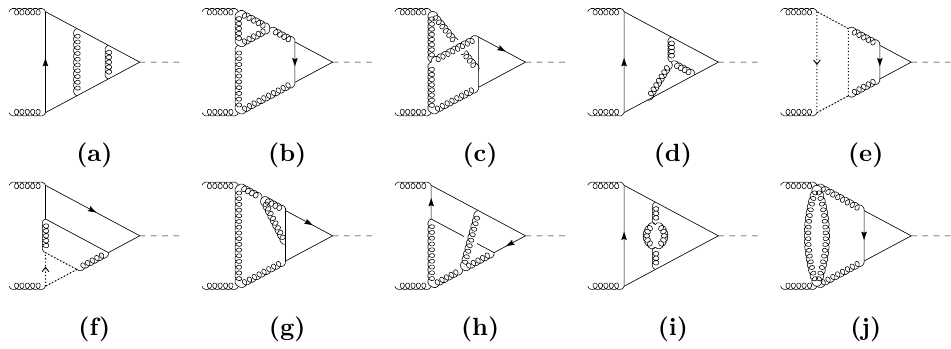
Figure 1. Sample Feynman diagrams to the leading color contribution to the ggH form